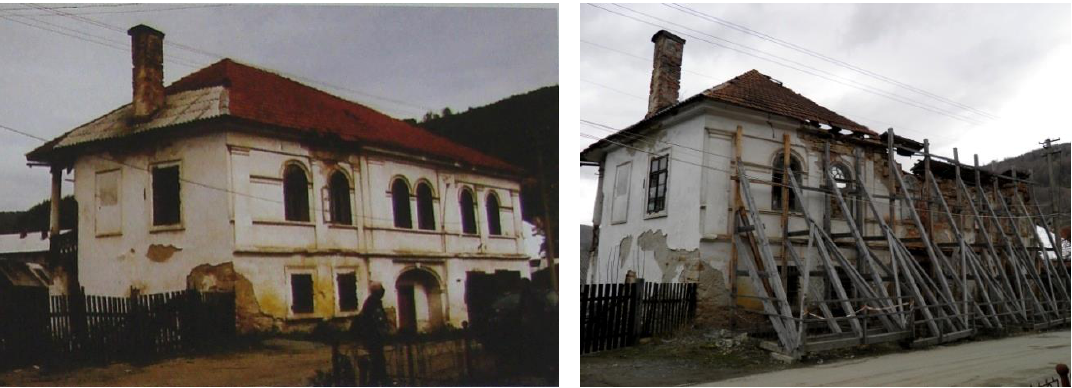
Figure 2: Reformed Parsonage ca. 2002 Figure 3: Reformed Parsonage in